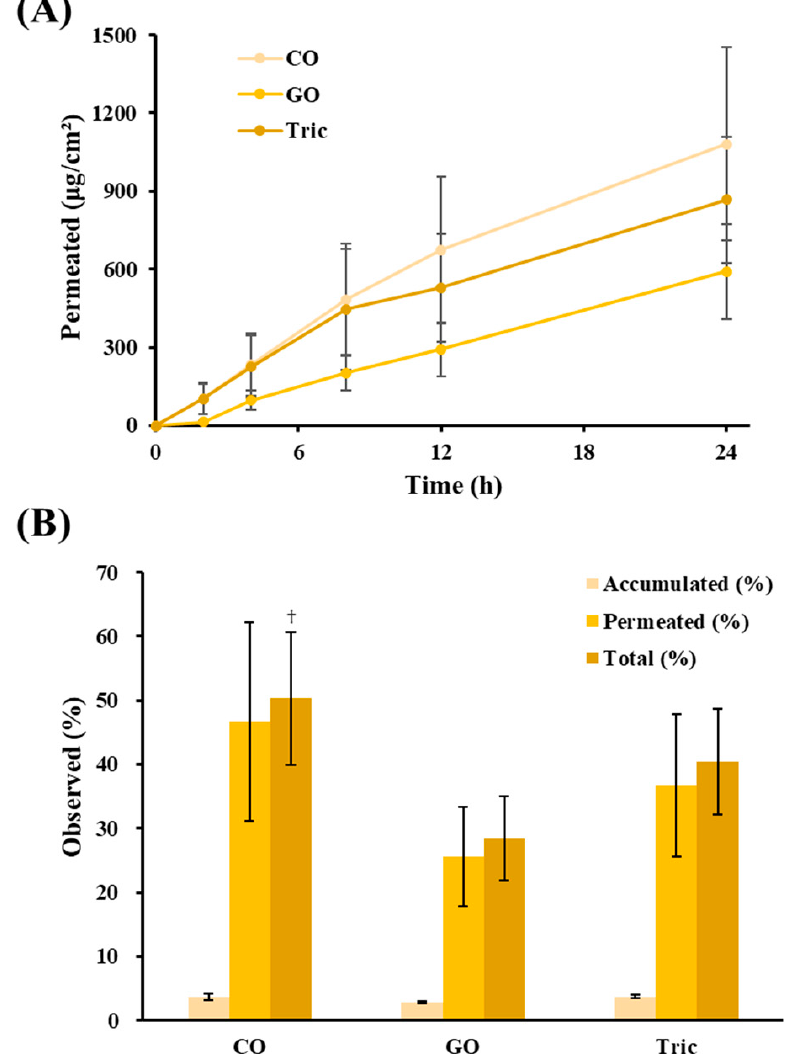
Figure 5. Ex vivo skin absorption of Vit C after topical administration of LOSs prepared with different oils. ( A ) Skin permeation profile ( µ g/cm 2 ) of Vit C across porcine skin. ( B ) Percent of Vit C accumulated in the skin, permeated across the skin, and the sum of Vit C accumulated and permeated 24 h post-administration of LOSs. LOSs prepared with camellia oil (L2), grapeseed oil (L4), and tricaprylin (L5) were named CO, GO, and Tric, respectively. Total absorbed (%) is calculated by dividing the sum of the accumulated and permeated amounts of Vit C by the initially applied amount of Vit C. Data represent mean ± SD (n = 3). † represents significant difference from GO ( † p <